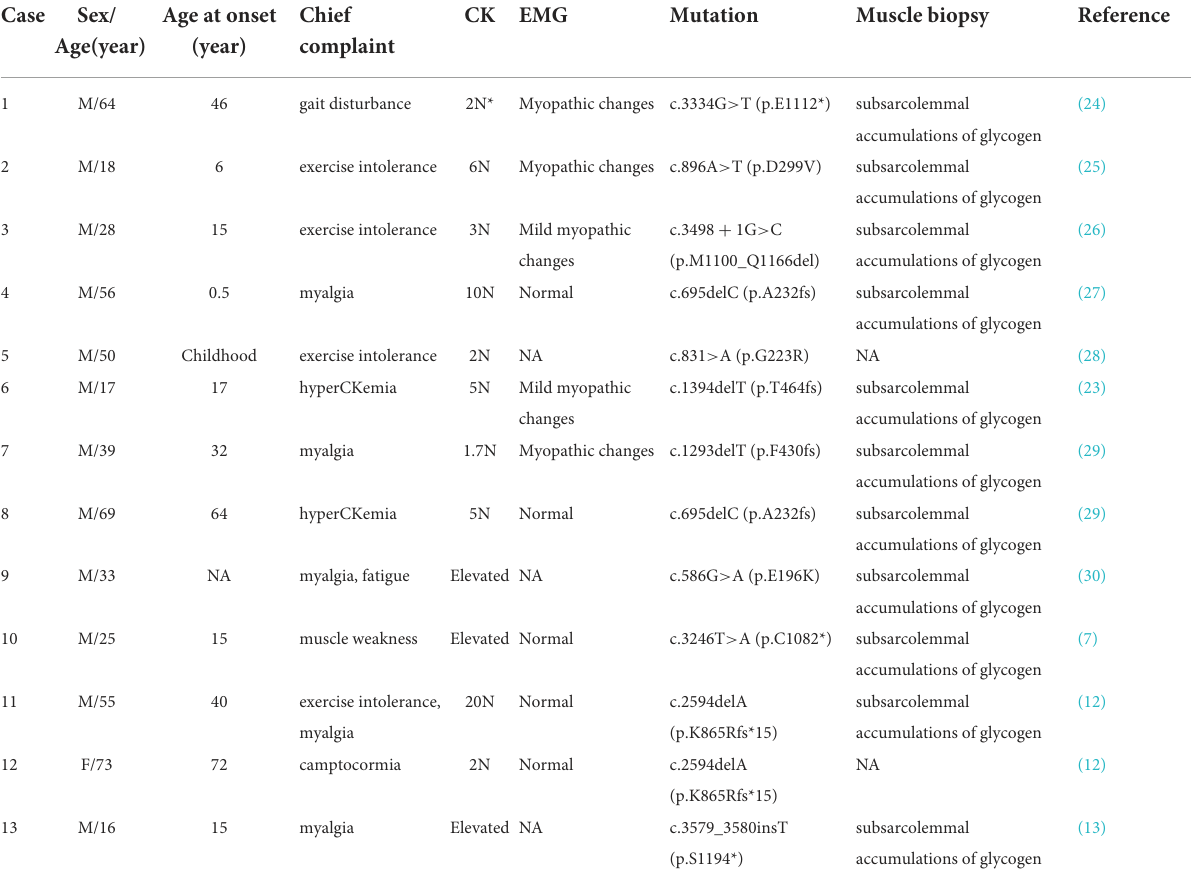
TABLE 3 Patients with GSD IXd harboring mutations in the PHKA1